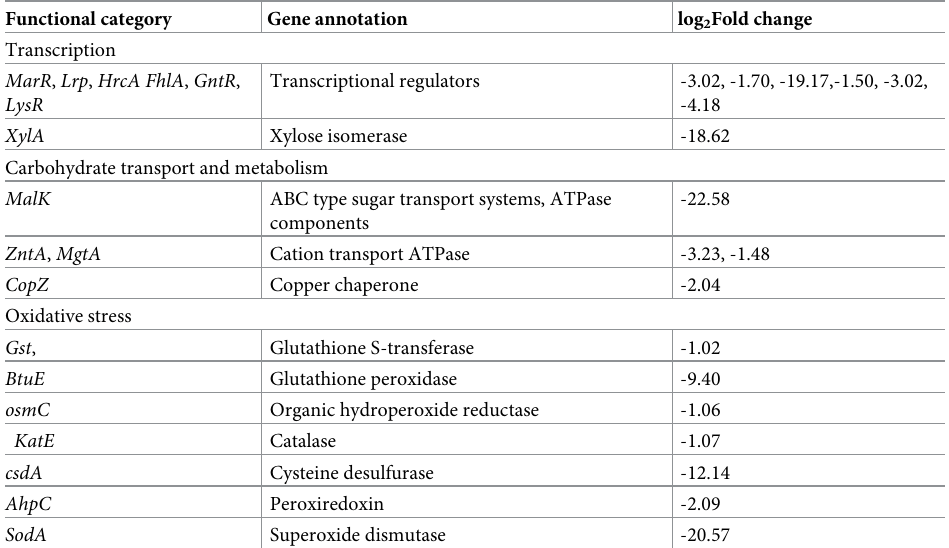
Table 4. Selected down-regulated genes under Cr(VI) stress in strain